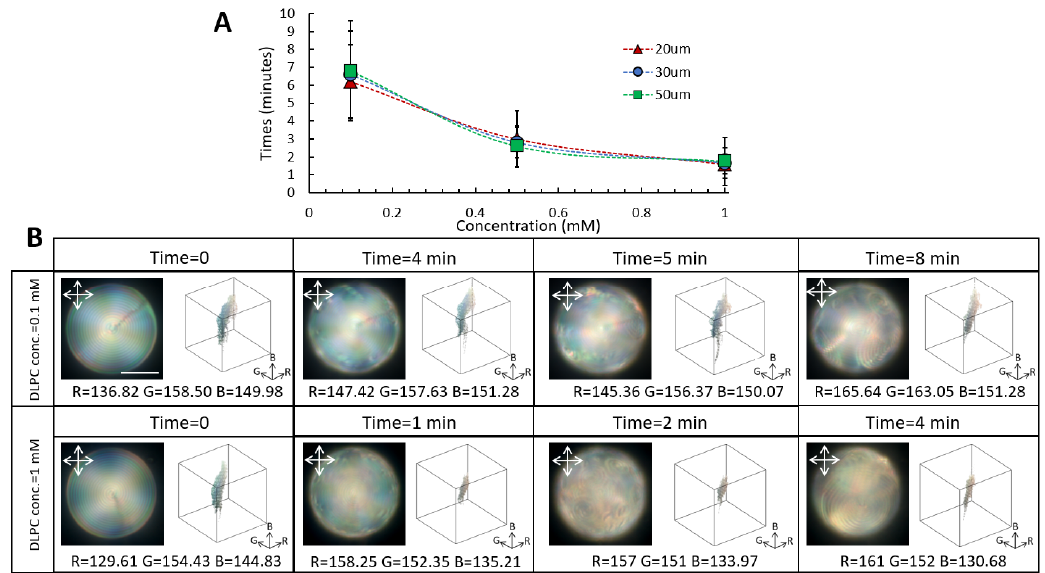
Figure 4. Response time of the low-chirality droplets as a function of droplet size and DLPC concentration. ( A ) Response time of the low-chirality droplets as a function of DLPC concentration for various droplet sizes. ( B ) Evolution of the colorimetric channels and color gamut of the 50 µm low-chirality droplets as a function of DLPC concentrations (scale bar = 20 µm).